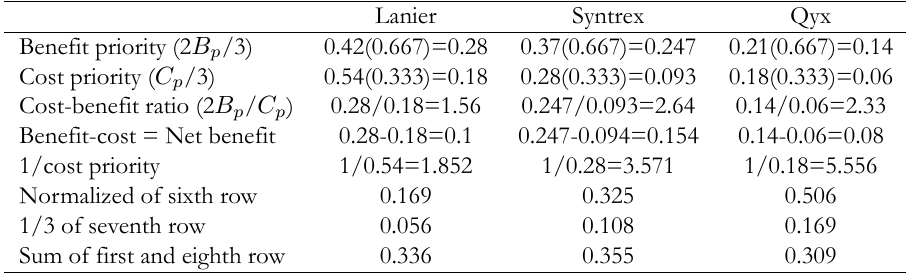
Table 3. Benefit weights, cost weights and cost-benefit ratio within one